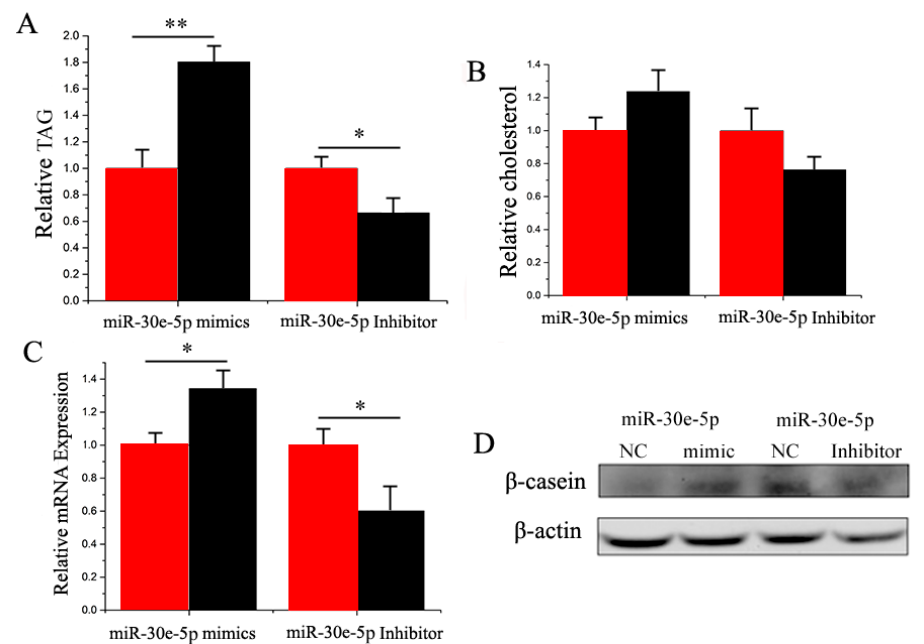
Figure 5. ( A ) Triglyceride levels in cells transfected with miR-30e-5p mimic or inhibitor; Triglyceride levels in transfected cells compared with miR-30e-5p controls ( n = 6). Red bars represent the negative control; black bars represent miR-30e-5p mimic or inhibitor; ( B ) Cholesterol levels in transfected cells compared with controls ( n = 6). Red bars represent the negative control; black bars represent miR-30e-5p mimic or inhibitor; ( C ) The expression of β -casein was quantified by RT-qPCR ( n = 6); ( D ): The effect of miR-30e-5p mimic or inhibitor on β -casein protein expression was evaluated by Western blot in GMEC. All experiments were duplicated and repeated three times. Values are presented as means ± standard errors, * p < 0.05; ** p < 0.01.